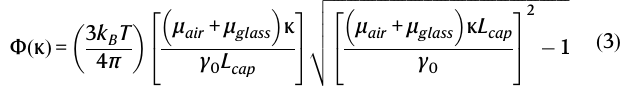
Fig. 1 | HCPCF core surface characterization. a Cross-section ofanSR-TLHCPCF. b Typical surface pro fi les for a fi ber drawn by using typical HCPCF fabrication methods measured by AFM (top plot) and optical pro fi lometry (bottom plot). c Typical AFM measurement result for a fi ber drawn by using typical HCPCF